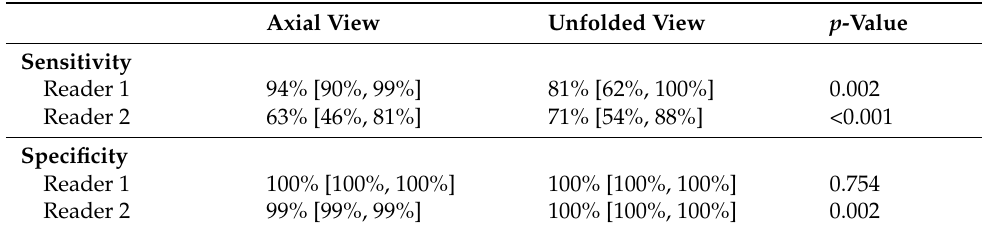
Table 3. Diagnostic accuracy on a per-rib basis considering repeated measures using a ratio estimator for the variance of clustered binary data. Values are given with the 95% confidence interval in square brackets. The p -values are calculated ignoring the correlation structure, analyzing the raw